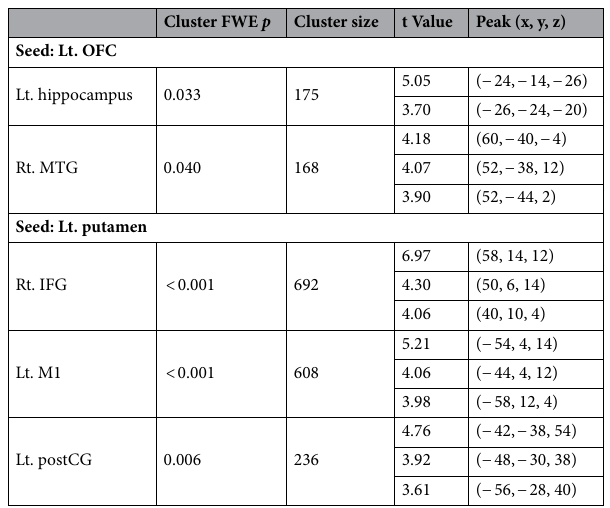
Table 3. Boxer specific functional connectivity ([Boxers (Time1) > Controls]). The statistical threshold for significant differences was set at FWE corrected p < 0.05, at the cluster level with uncorrected p < 0.001 at the voxel level. Lt, left; Rt, right; MTG, middle temporal gyrus; IFG, inferior frontal gyrus; M1, primary motor cortex; postCG, postcentral gyrus.